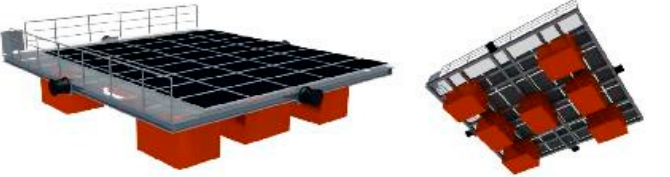
Figure 5. Floating Solar Park [33]. [Permission of using the figure has been requested from the copyright holder Moss Maritime].